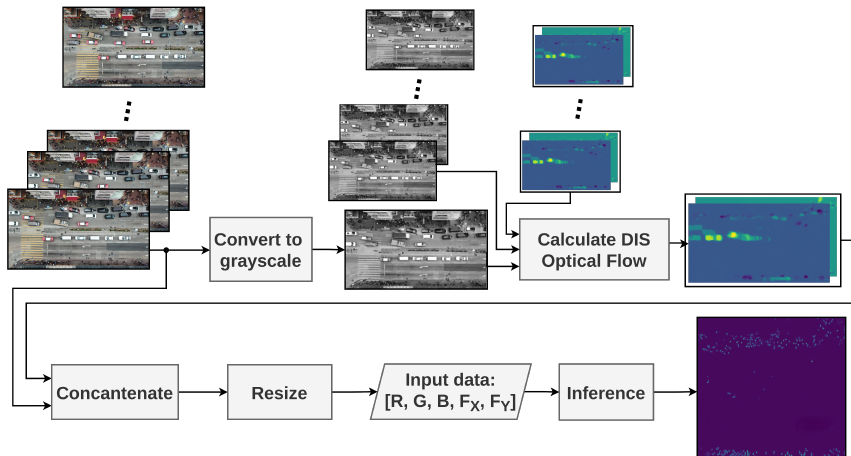
Figure 4. Crowd-counting model inference